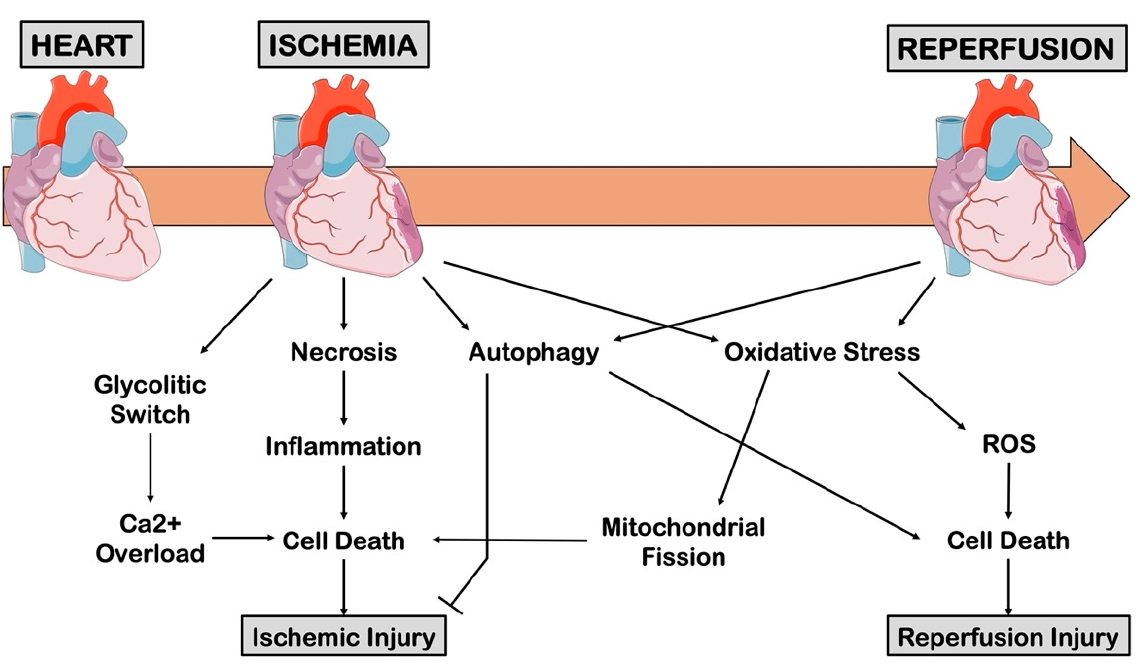
Figure 1. Schematic representation of the molecular mechanisms contributing to ischemia and reperfusion injury. The figure was made in part using tools provided by Servier Medical Arts. Reperfusion reintroduces the substrates for ATP generation and oxygen, allowing pH normalization and the wash-out of catabolic wastes. These factors are of paramount importance for the survival of myocardial tissue, but in cardiomyocytes with a significant ischemic insult the same factors may paradoxically exacerbate cell injury, determining the transition from reversible to irreversible damage. Reperfusion induces a rapid normaliza- tion of the extracellular pH that determines the formation of a strong H + gradient across the plasma membrane. The main result is a further massive flow of Na + inside the cell to enable the expulsion of excess H + ions through the Na + /H + exchanger. The increase of intracellular Na + forces the sodium-calcium exchanger (NCX) to operate unconventionally, secreting Na + outside the cell to balance its accumulation and importing Ca 2+ [23]. It takes 30–60 min to reestablish physiological calcium levels, and the transient accumulation of this ion in the cytoplasm is sufficient to activate calcium-dependent lipases and proteases and trigger cell hyper-contraction and mitochondrial permeability transition pore (mPTP) opening [24]. Even though the exact composition of the mPTP core remains to be fully clari- fied, an increasing consensus is gathering around a structural role for adenosine nucleotide transporter (ANT) [25] and F 0 F 1 -ATP synthase [26]. Voltage-dependent anion-selective channel (VDAC), hexokinase, creatine kinase, B-cell lymphoma 2 (Bcl-2), Bcl-2 homologous receptor, glycogen synthase kinase 3 beta (GSK3- β ), PKC ε , protein kinase G (PKG),